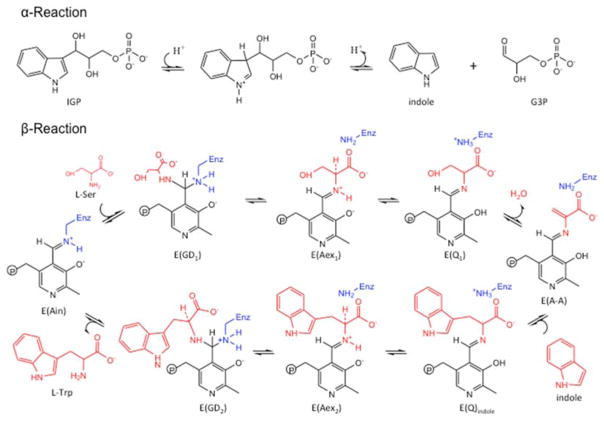
Overall chemical reactions in TRPS.